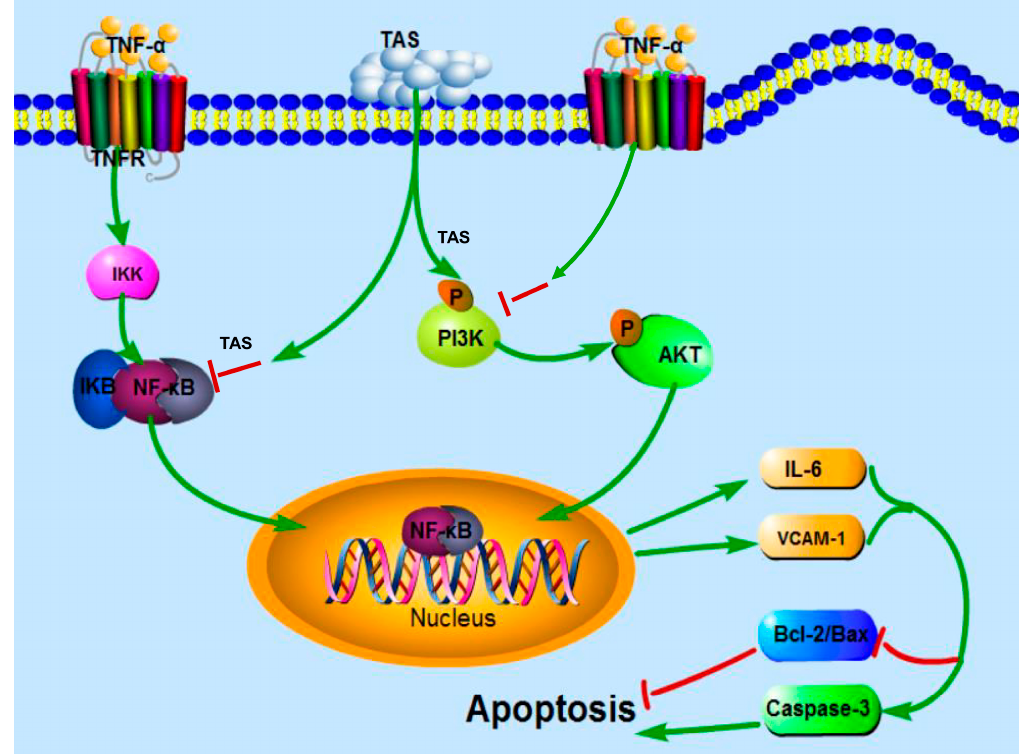
Figure 9. Schematic diagram of the mechanism by which TAS protects against TNF- α -mediated HUVEC injury. TAS suppresses the inflammation and apoptosis of HUVECs induced by TNF- α via PI3K/Akt signalling and NF- κ B signalling pathways. TAS stands for total saponins of Aralia elata (Miq.).